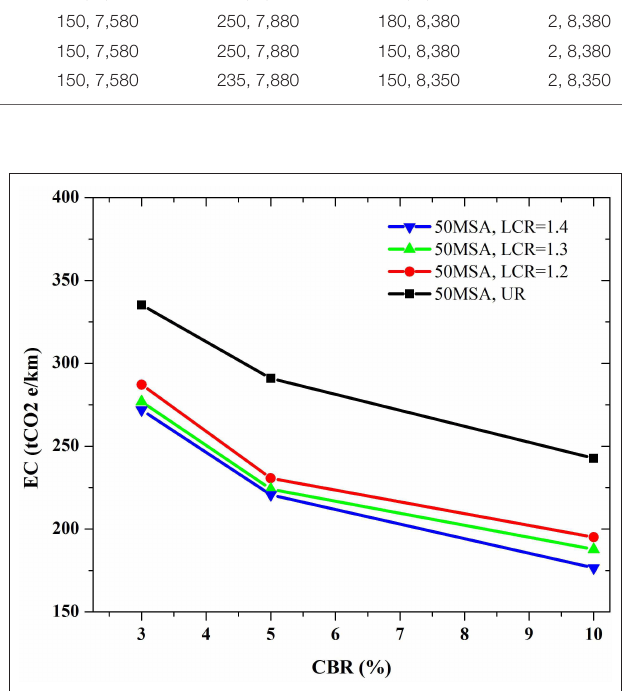
FIGURE 6 | Variation of EC values with subgrade CBR for unreinforced and geogrid reinforced pavement structures that cater to a traffic of 50 MSA.